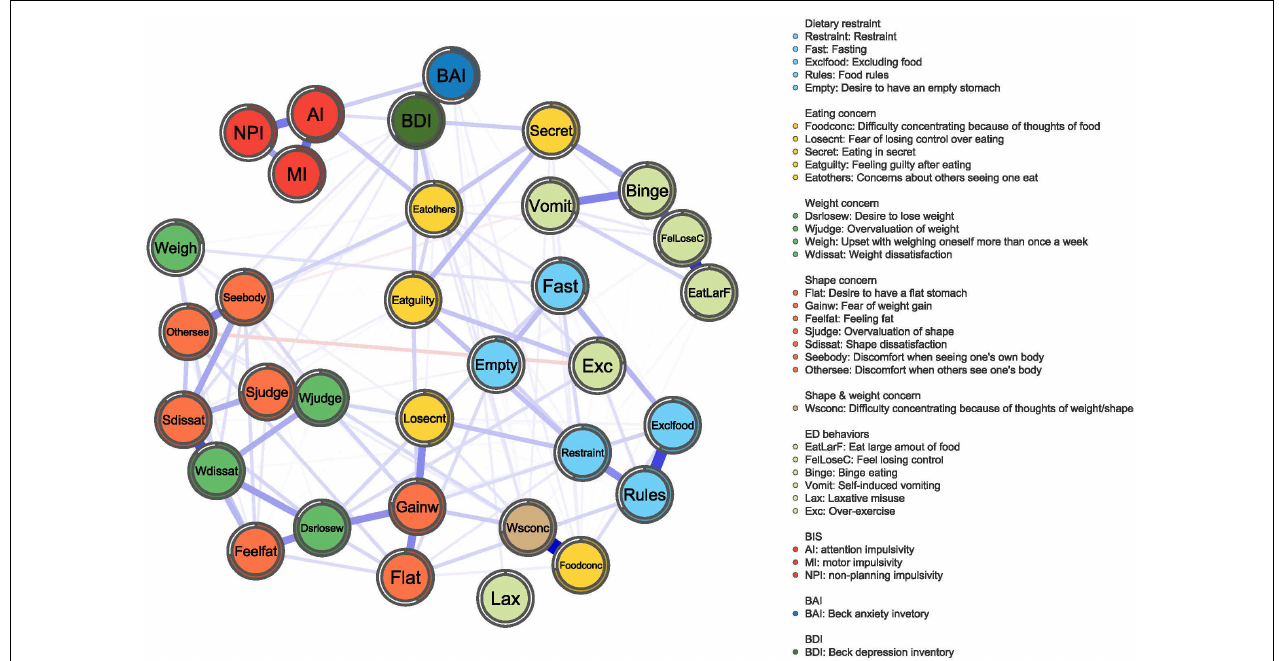
FIGURE 1 | BN network. The network graph shows associations and predictability estimates between ED symptoms (i.e., fear of weight gain, Shape dissatisfaction, Weight dissatisfaction, and Restraint), depression symptoms, anxiety symptoms, and impulsivity (i.e., attention impulsiveness, motor impulsiveness, and unplanning impulsiveness) in BN. The edges represent the strength of association between nodes. The colors of the node indicate the different subscales.